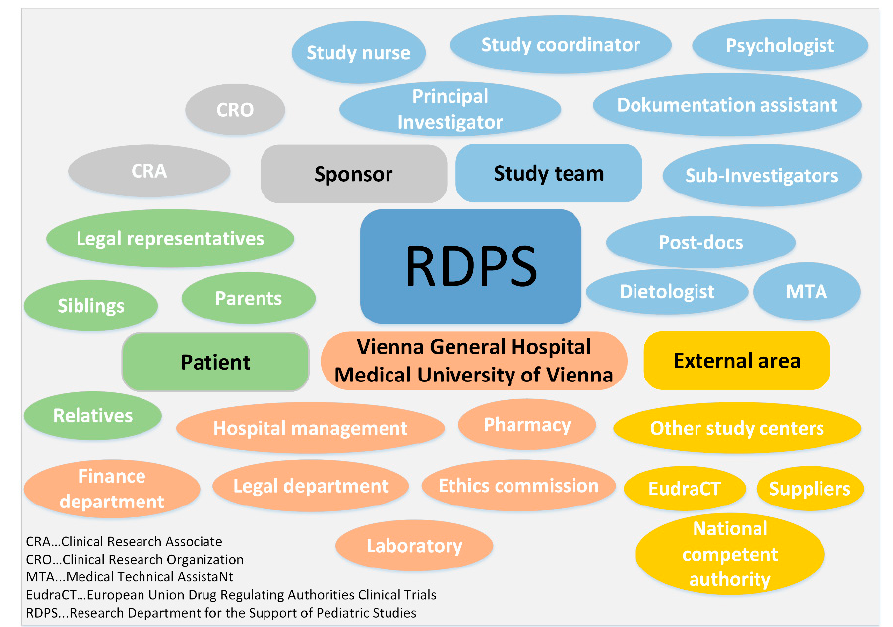
Figure 4. RDPS task environment - communication with stakeholders.